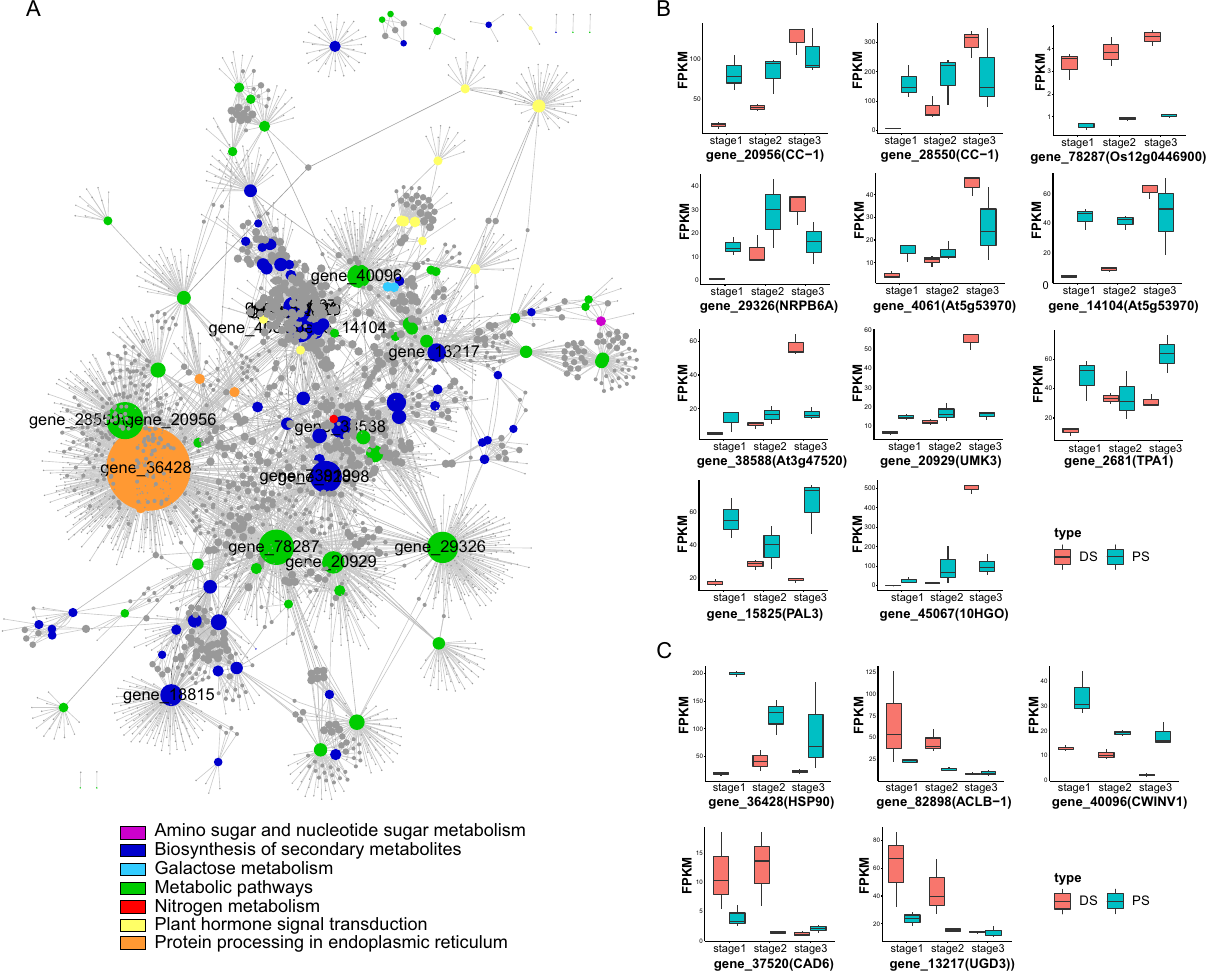
Figure 4. Identification and expression patterns of key regulatory genes in the common pathways. ( A ) Protein– protein interaction network of DEGs in common pathways. The size of each node indicates the interaction degree to other nodes. Nodes with gene ID represent genes whose degree was higher than 100. ( B ) Expression profiles of up-regulated genes with more than 100 degrees. ( C ) Expression profiles of down-regulated genes with more than 100